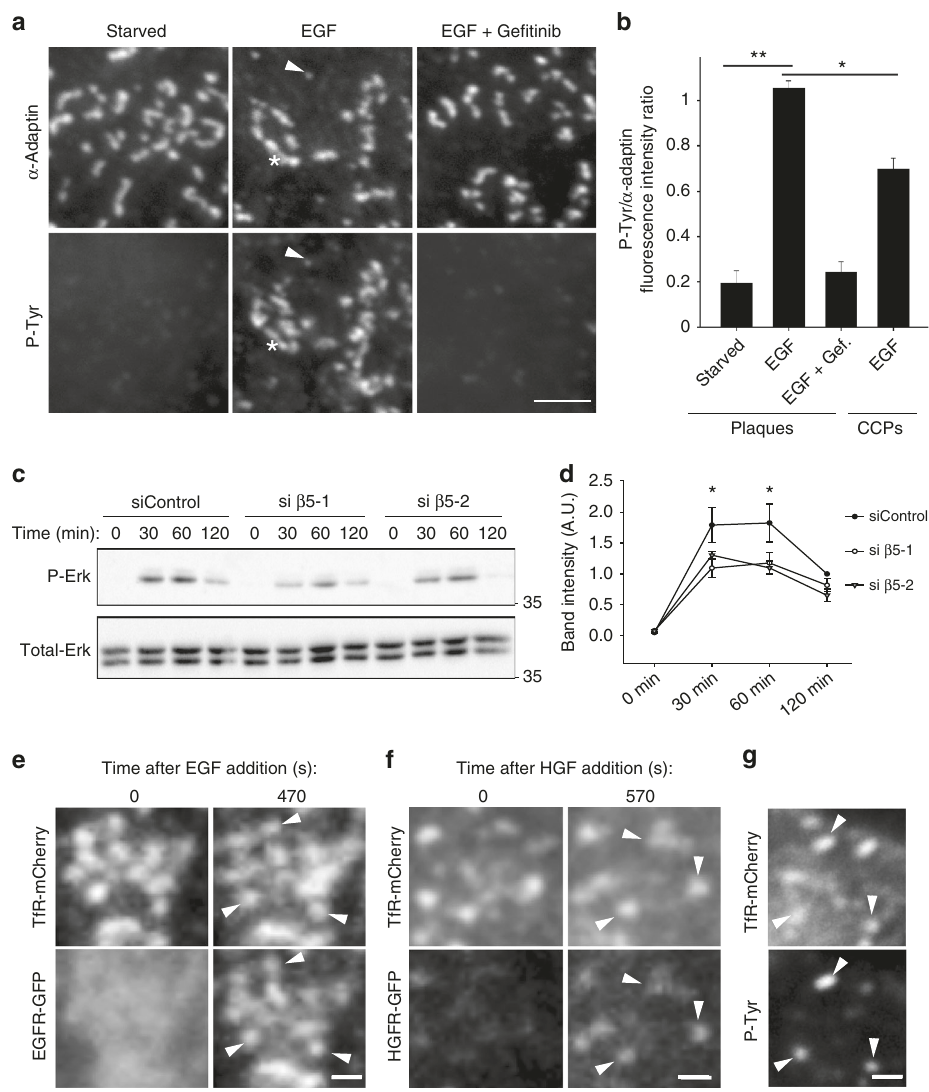
Fig. 5 Clathrin-coated plaques locally regulate receptor-dependent Erk signaling. a HeLa cells seeded on collagen-coated glass were starved for 4 h and then treated or not with 10 ng/ml EGF for 5 min alone or added after 30 min preincubation with 10 µ M Ge fi tinib. Cells were then fi xed and stained for α - adaptin and phosphotyrosines. The arrowhead points to one CCP and the star marks a plaque. Scale bar: 2 μ m. b Quanti fi cation of phosphotyrosines accumulation at plaques or CCPs in the indicated conditions. Results are expressed as mean ± SD (* P < 0.05, ** P < 0.001, one-way analysis of variance — ANOVA. n = 3. Number of structures analyzed per condition: Starved 160 plaques; EGF: 452 plaques, EGF + Ge fi tinib: 301 plaques, CCPs/EGF: 200 pits). c Western-blot analysis of phospho-Erk (P-Erk) levels in starved HeLa cells treated with control or β 5-speci fi c siRNAs as indicated, and stimulated for the indicated time with 10 ng/ml EGF. Total-Erk was used as a loading control (representative image of three independent experiments). d Densitometry analysis of bands obtained in western-blots as in c . Results are expressed as mean ± SD (* P < 0.05, ANOVA. n = 3). e HeLa cells treated with β 5-speci fi c siRNAs were transfected with plasmids encoding for TfR-mCherry and EGFR-GFP and seeded on anti-mCherry antibodies-coated glass. Cells were serum- starved for 4 h and then treated with 10 ng/ml EGF for 470 s. Scale bar: 0.5 μ m. Arrowheads point to plaques positive for EGFR-GFP. f HeLa cells treated with β 5-speci fi c siRNA were transfected with plasmids encoding for TfR-mCherry and HGFR-GFP and seeded on anti-mCherry antibodies-coated glass. Cells were serum-starved for 4 h and then treated with 50 ng/ml HGF for 570 s. Scale bar: 0.5 μ m. Arrowheads point to plaques positive for HGFR-GFP. g HeLa cells treated with β 5-speci fi c siRNA were transfected with plasmids encoding for TfR-mCherry and seeded on anti-mCherry antibodies-coated glass. Cells were serum-starved for 4 h and then treated with 10 ng/ml EGF for 5 min prior to fi xation and staining for phosphotyrosines. Scale bar: 1.5 μ m. Arrowheads point to plaques positive for